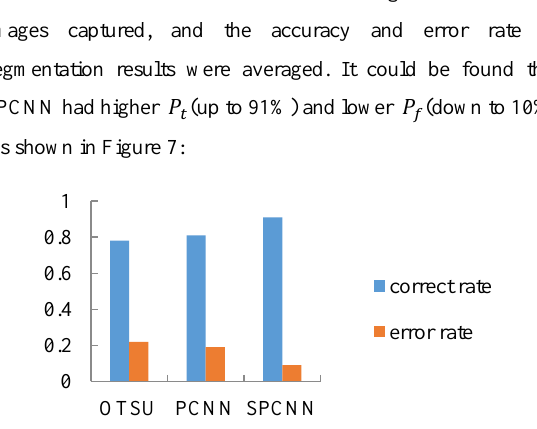
Figure 7. Accuracy and error rate of three segmentation algorithms